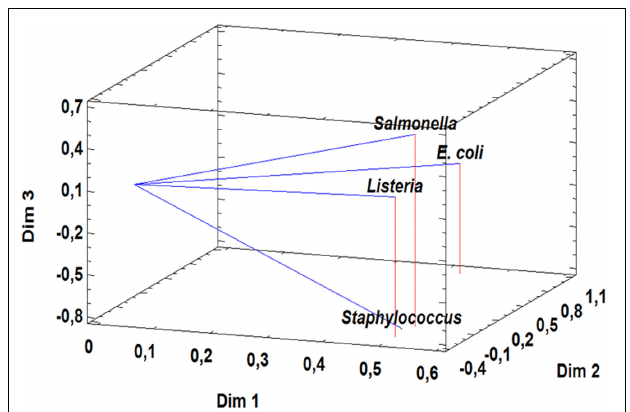
FIGURE 1 | Principal Component Analysis of co-aggregation capacity with Gram-positive and Gram-negative pathogens ( Listeria innocua CECT 910, Staphylococcus aureus CECT 4468, Escherichia coli CCUG 47553, Salmonella Enteritidis UJ3449) for 31 L. pentosus strains.